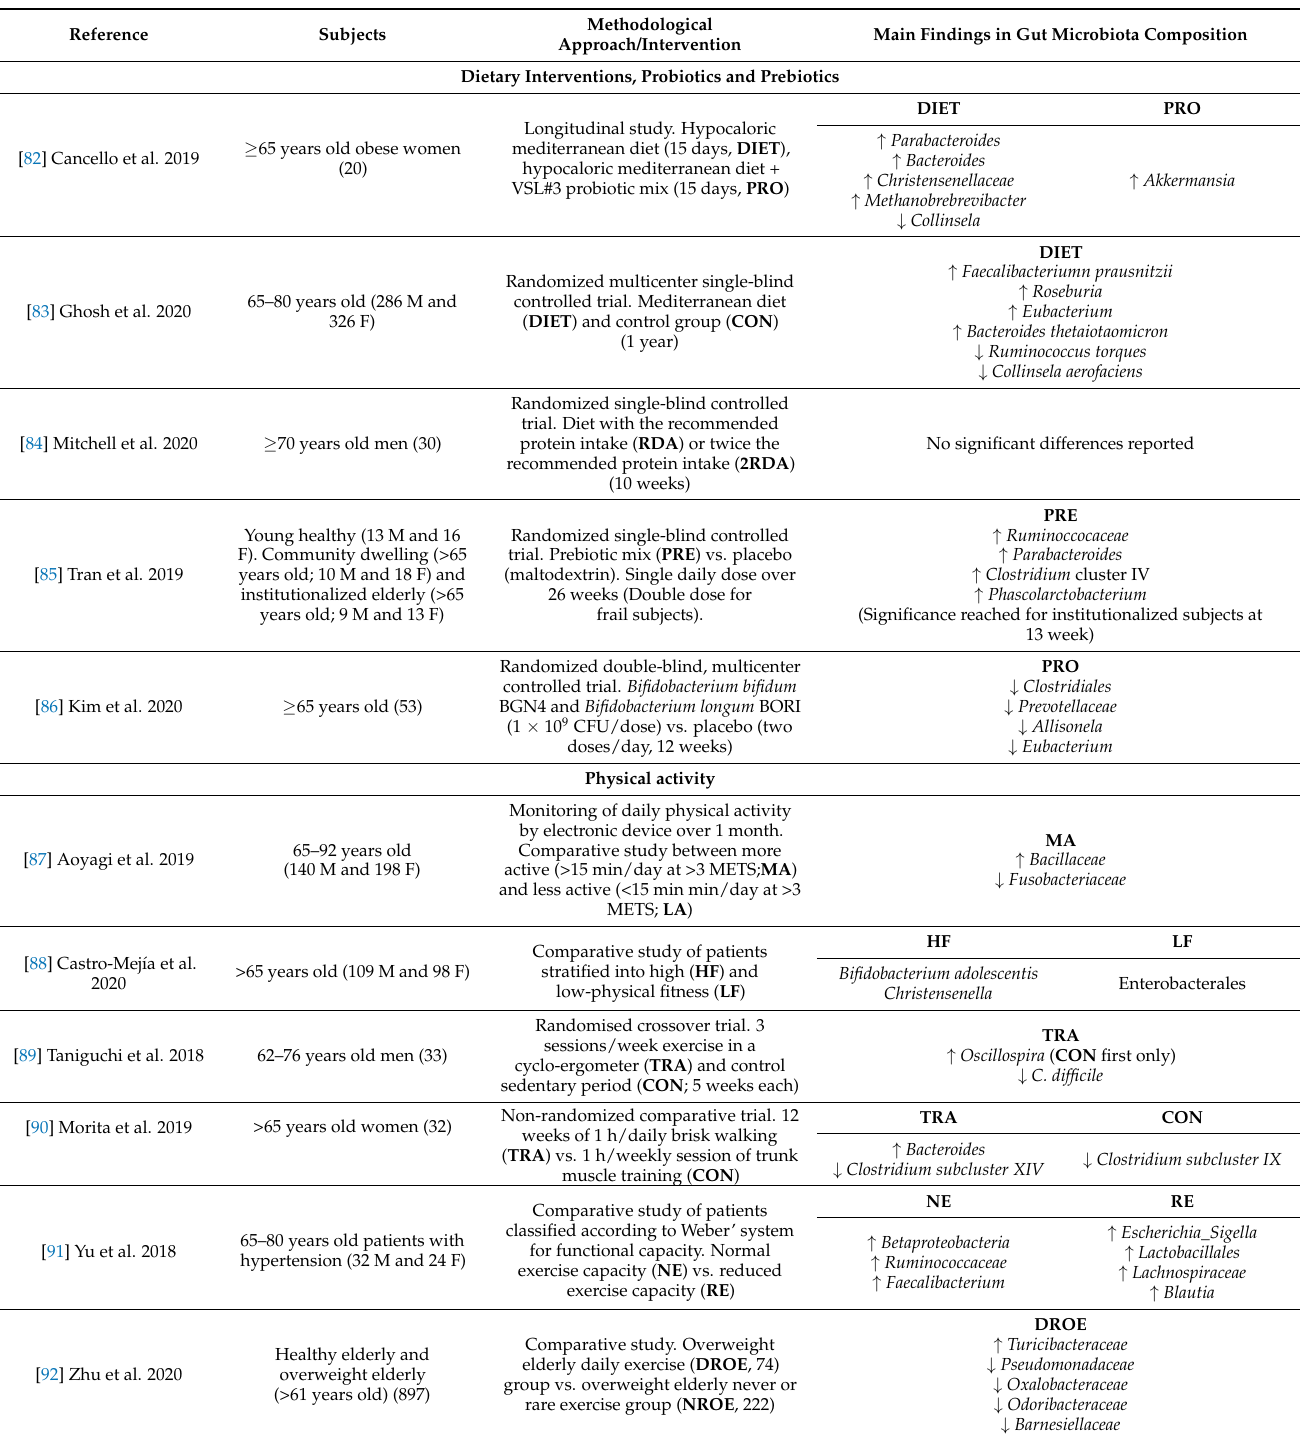
Table 2. Dietary interventions, supplementation with probiotics and prebiotics and assessment of the effect of physical activity on elderly individuals, with or without the concurrence of metabolic